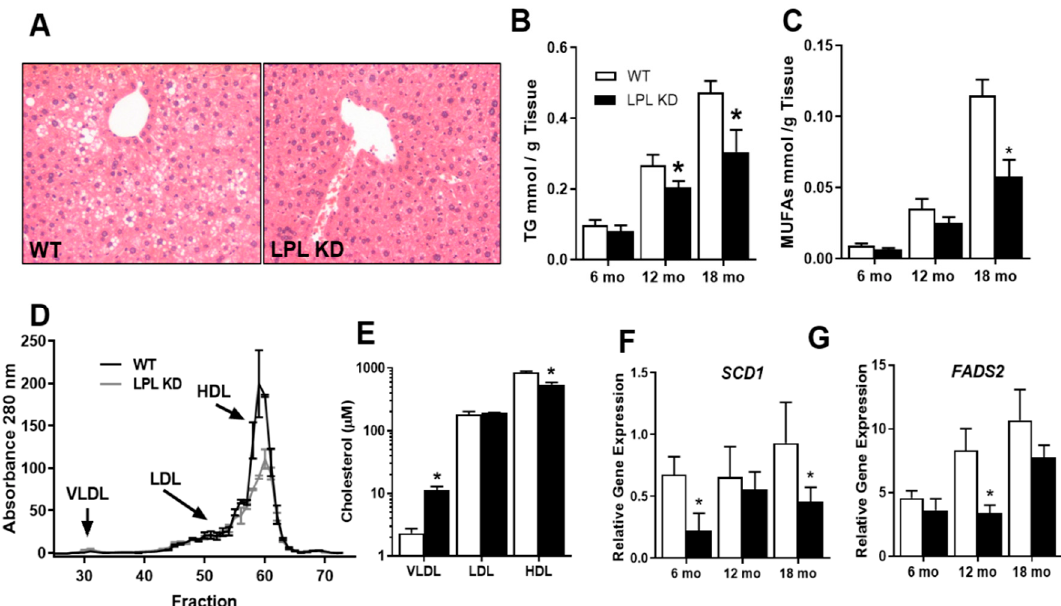
Figure 2. Hepatic lipid accumulation is reduced in neuron-specific LPL KD mice. ( A ) Hematoxylin and eosin stained liver of 12 months WT (LPL flox ) and LPL KD (NEXCreLPL flox ) mice. ( B ) Hepatic triglyceride (TG) concentration in LPL KD (black bars) compared to WT mice (white bars) at 6, 12, and 18 months. ( C ) Hepatic mono-unsaturated fatty acid (MUFA) concentration reduced in LPL KD mice compared to WT mice at 6, 12, and 18 months. ( D ) Fast protein liquid chromatography (FPLC) fractionation of lipoproteins from plasma of LPL KD and WT mice at 18 months. ( E ) Cholesterol content of lipoprotein fractions at 18 months. ( F , G ) Relative gene expression of SCD1 and FADS2 at 6, 12, and 18 months. (* = p < 0.05 vs. aged-matched WT controls).